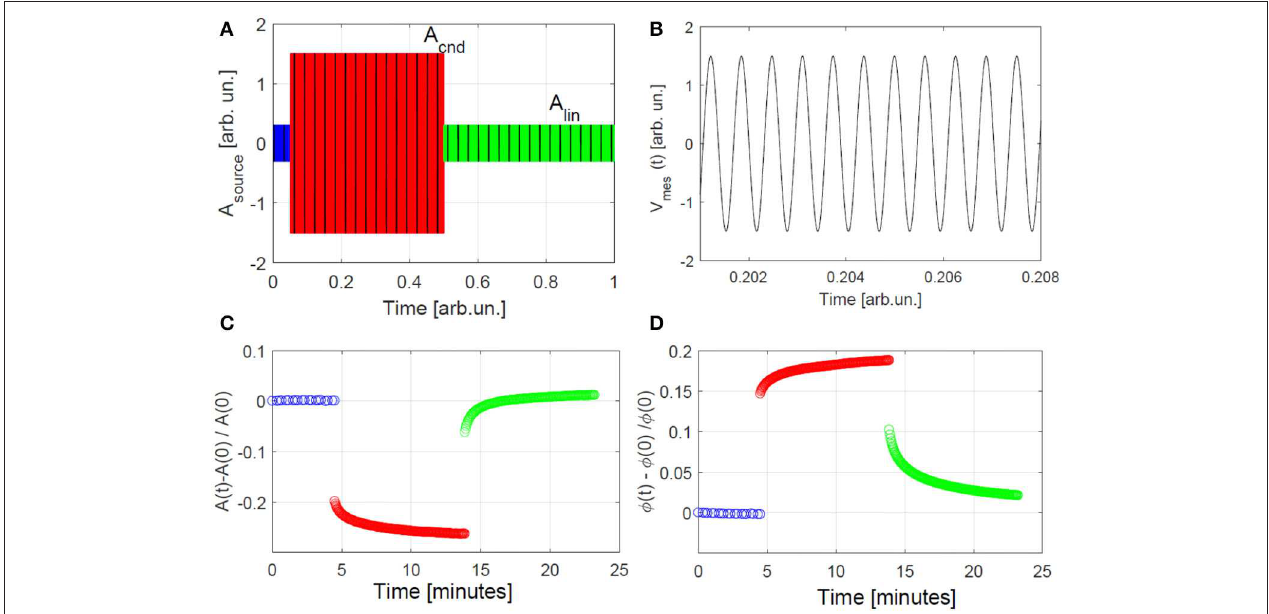
FIGURE 8 | MoDaNE protocol to extract slow dynamics on the damaged concrete sample. (A) Schematic representation of the source function: a sinusoidal wave is applied at low, large, and low amplitude again. Black lines highlight the times at which the output signal is detected (B) . Example of one temporal signal recorded in one of the windows shown in (A) . The temporal signal is a sinusoidal function from which amplitude and phase at the given time could be derived. (C,D) Plots of the amplitude and phase variations with respect to those detected at time t = 0.